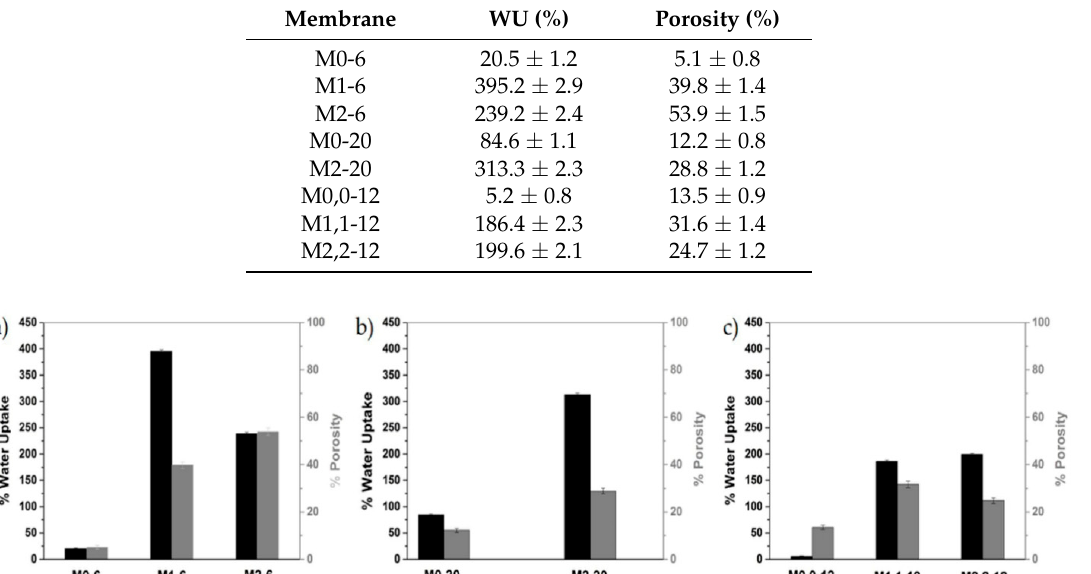
Table 8. WU and porosity values for membranes M0-6, M1-6, M2-6, M0,0-12, M1,1-12, and M2,2-12. Membrane